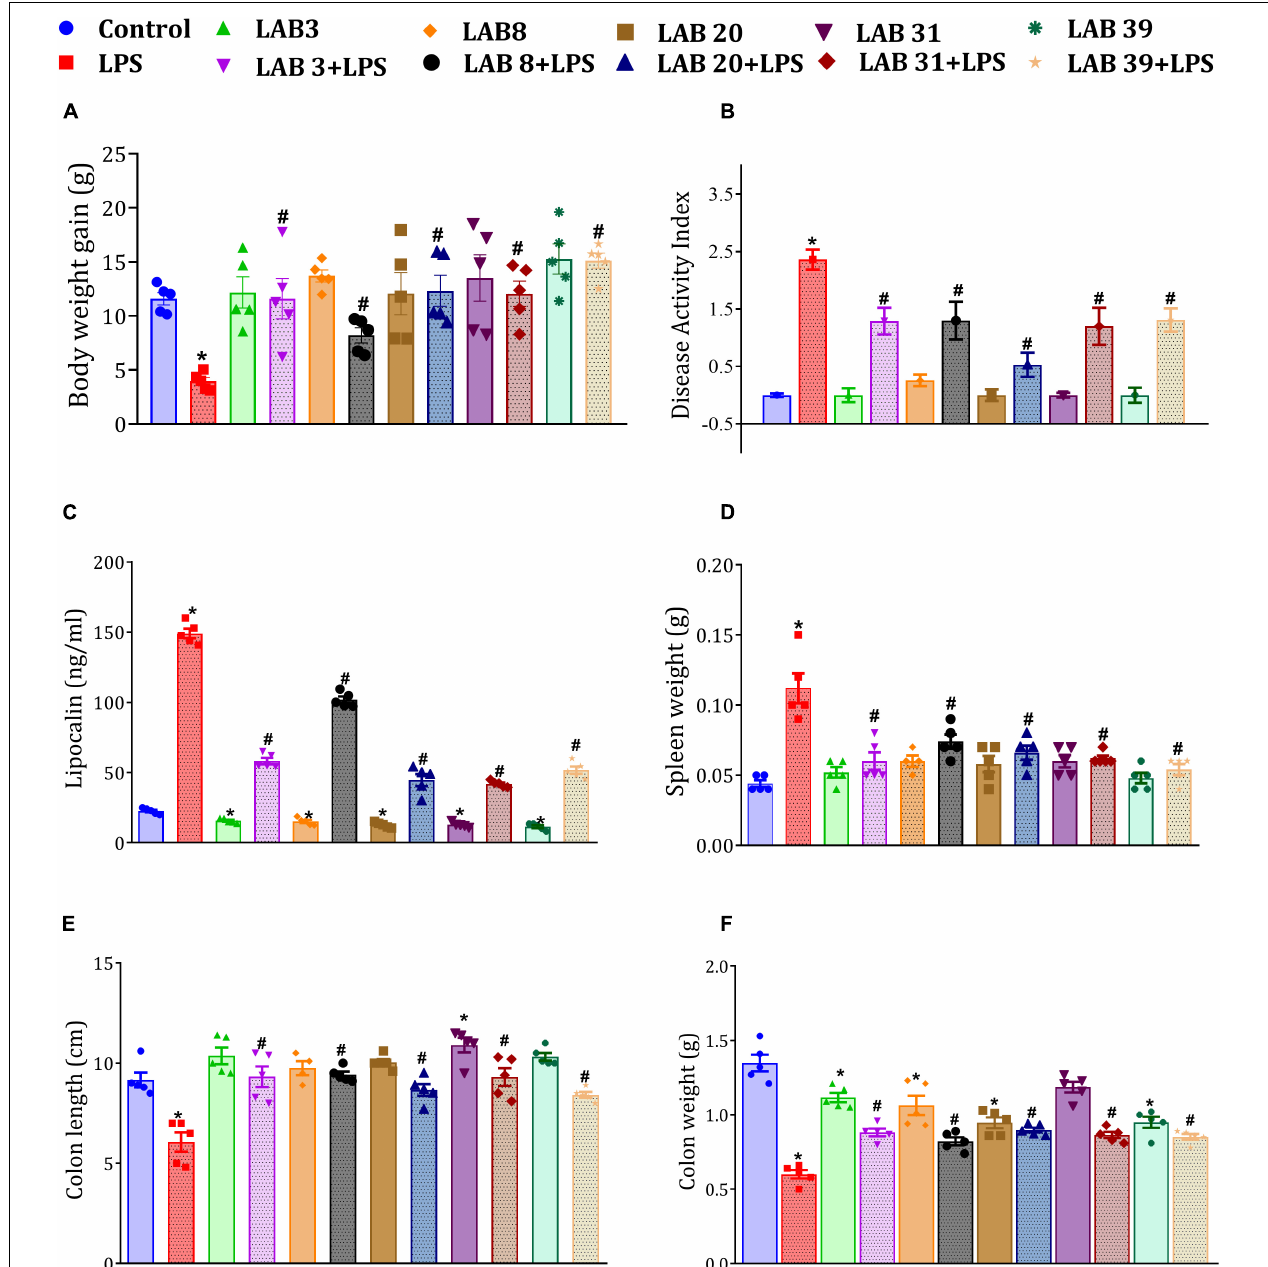
FIGURE 2 | Effect of LAB supplementation on: (A) Weight gain; (B) disease activity index; (C) fecal lipocalin levels; (D) spleen weight; (E) colon length; and (F) colon weight. Data were analyzed by one-way ANOVA with Tukey’s post hoc test ( P ≤ 0.05). *Significant relative to control; #significant relative to LPS-treated animals ( N =